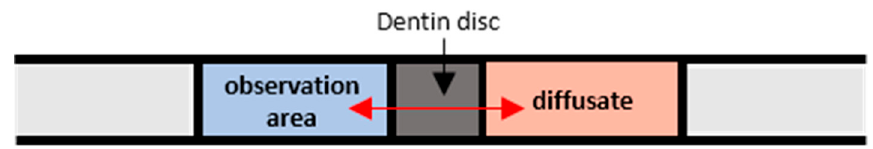
Figure 2 . Schematic of the experimental conduit. Reproduced with permission from [17].